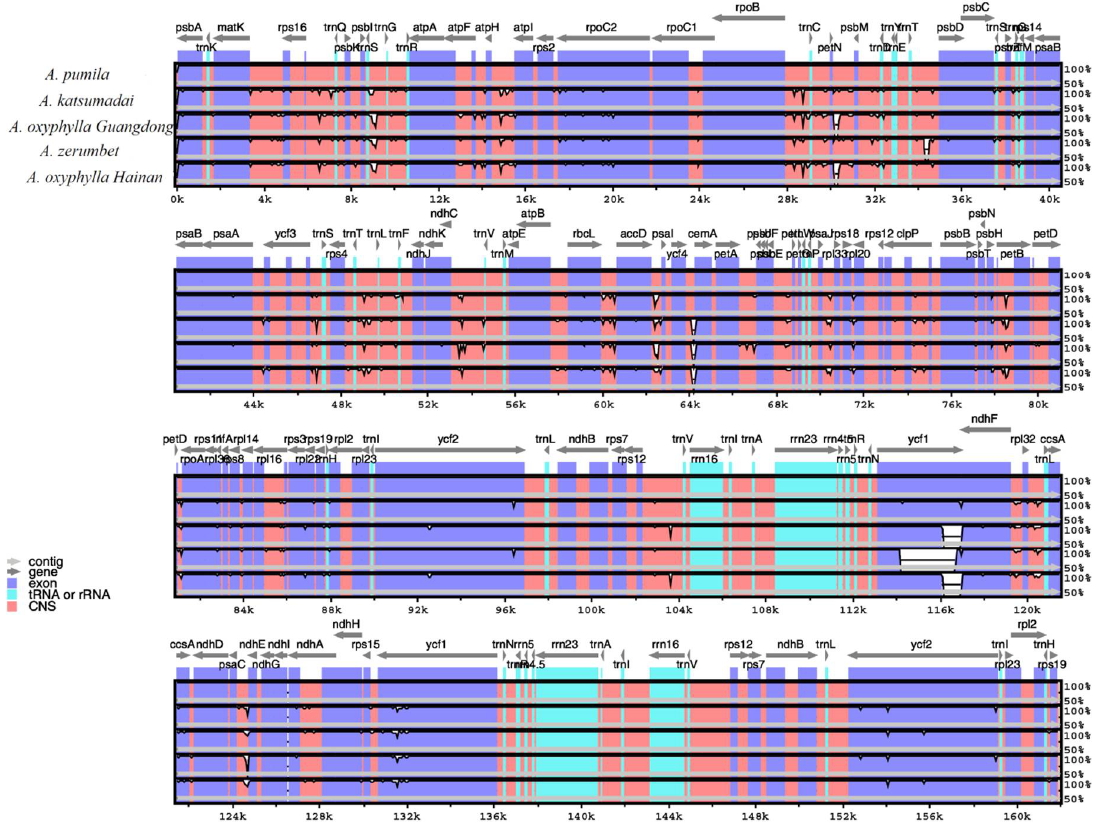
Figure 6. Complete chloroplast genome comparison of five Alpinia accessions using the chloroplast genome of A. pumila as a reference. Gray arrows and thick black lines above the alignment indicate gene orientation. Purple bars represent exons, sky-blue bars represent transfer RNA (tRNA) and ribosomal RNA (rRNA), red bars represent non-coding sequences (CNS), and white peaks represent differences of chloroplast genomes. The y-axis represents the identity percentage ranging from 50 to 100%.